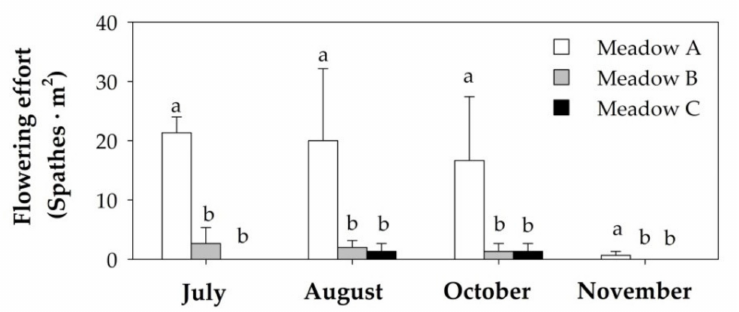
Figure 4. Flowering effort (mean + SE; n = 3) of the three studied human dominated Z. noltei meadows from July to November of 2019. Different letters above error bars indicate significant differences among